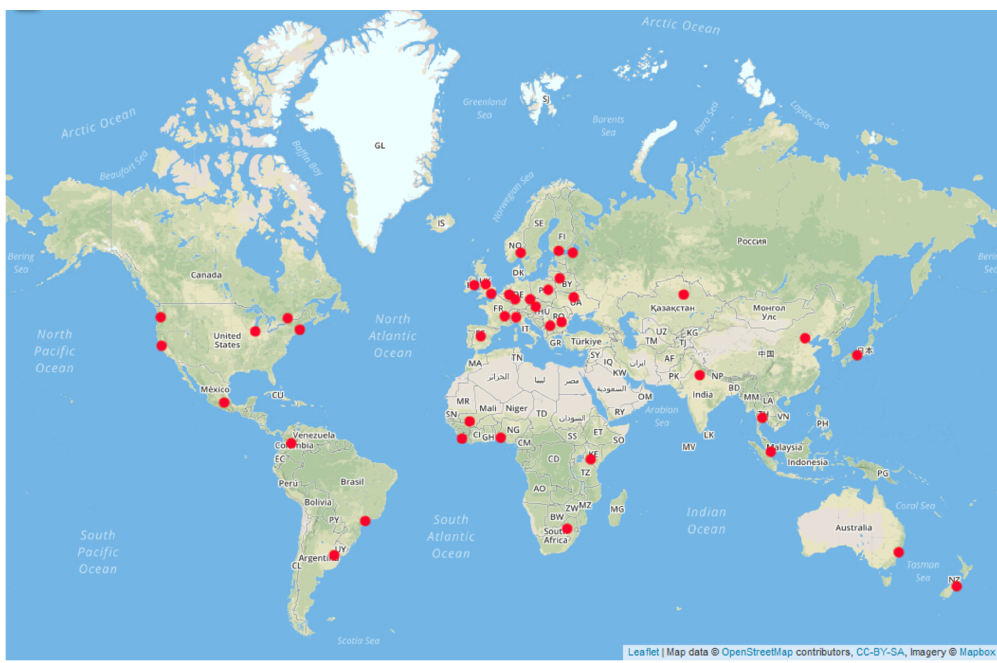
Figure 4. A map showing the locations of the 40 cities and urban areas that were used in the analysis for this